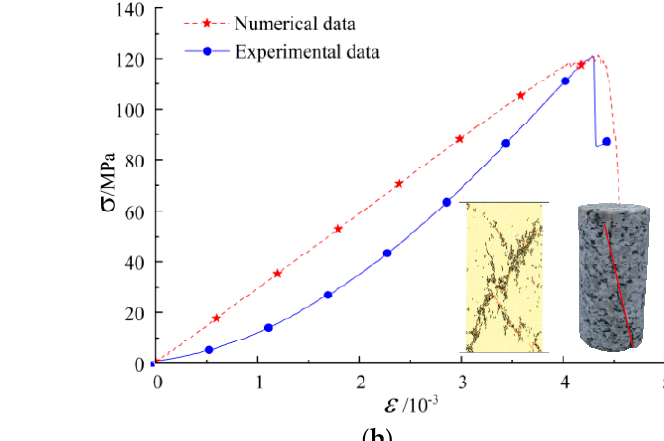
Table 2. Meso mechanical parameters of calculation model.